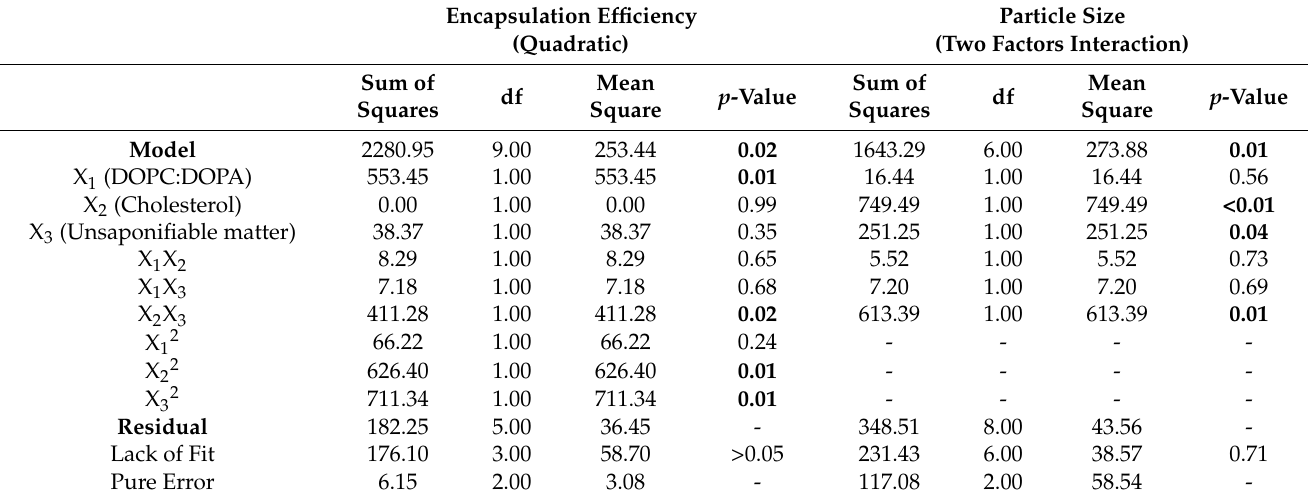
Table 2. Surface response model ANOVA table per output variable (fitted